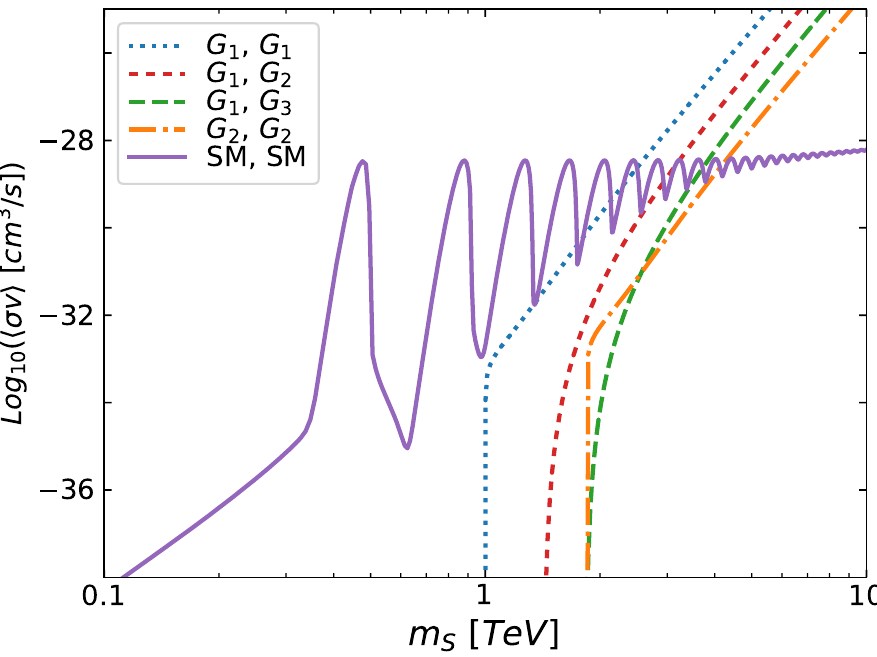
Figure 1 . Contributions to the scalar DM annihilation cross-section due to KK-gravitons, for (cid:3) = 100 TeV and m G = 1 TeV, as a function of the DM mass m S . The solid purple line corresponds 1 to the DM annihilation into SM particles through virtual KK-graviton exchange, (cid:27) ve ;G . The non- solid lines correspond to DM annihilation into two KK-gravitons, (cid:27) GG : from left to right SS ! ( G 1 ; G 1 ) ; ( G 1 ; G 2 ) ; ( G 2 ; G 2 ) and ( G 1 ; G 3 ),